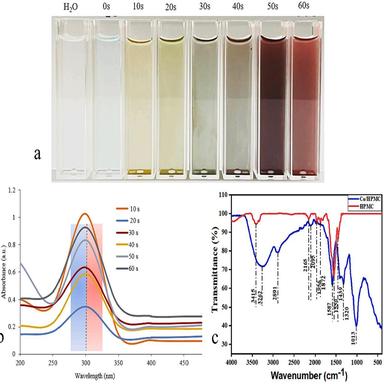
(a) Visual observation on the synthesis of copper nanoparticles in the HPMC matrix at various microwave treatment times (10–60 s); (b) Combined UV-Visible spectra of copper nanoparticles on HPMC matrix at various treatment times; (c) FT-IR analysis of copper nanoparticle on HPMC matrix (blue) and pure HPMC (red). (For interpretation of the references to colour in this figure legend, the reader is referred to the web version of this article.)